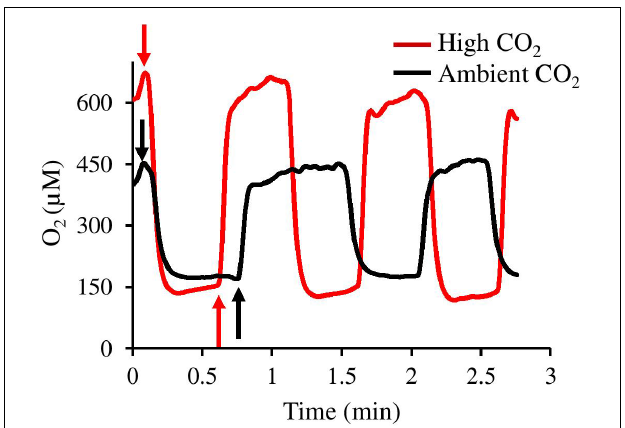
FIGURE 5 | Surface O 2 concentration dynamics of CCA recruits during light-dark shifts under ambient CO 2 (black line, CO 2 between 400.8 and 448.1 µ atm, pH 8.0–8.03) and high CO 2 (red line, CO 2 between 998.9 and 1070.6 µ atm, pH 7.67–7.70). Upward arrows and downward arrows exemplify onset of light and dark periods,